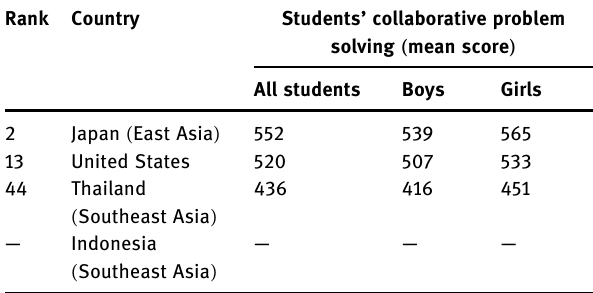
Table 11: Summary of students ’ collaborative problem - solving program for international student assessment ( PISA ) Rank Country